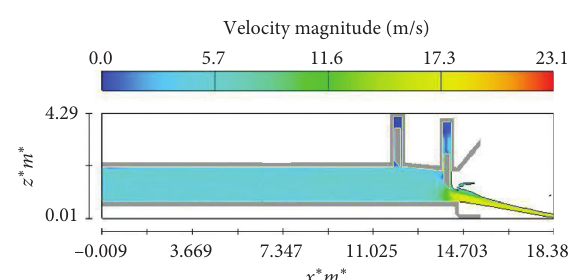
Figure 12: Output velocity of the gate and valve in 40% gate and 100% valve opening.